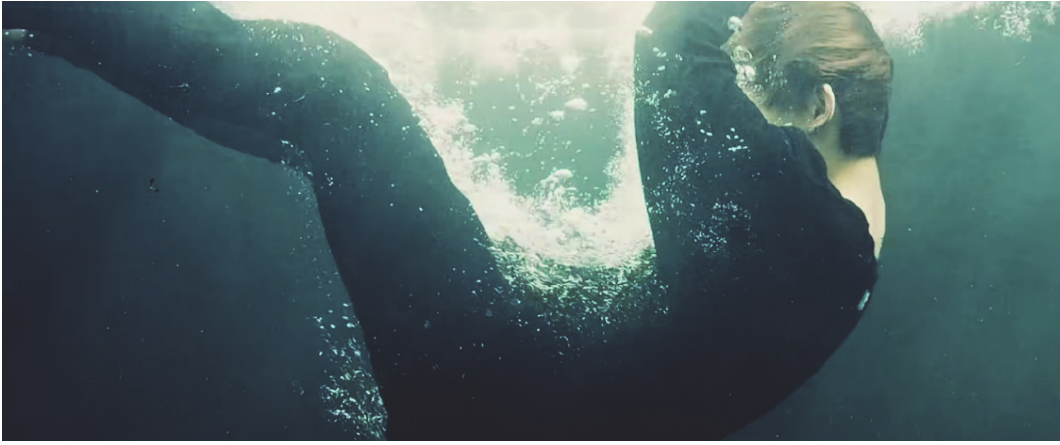
<Figure 6> Image of Suicide/Self-Harm in BTS. (2015b). “Run”